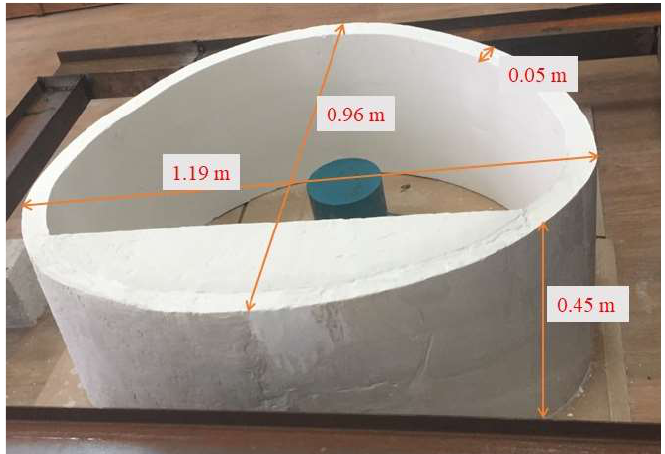
Figure 3. Similar lining model of tunnel.